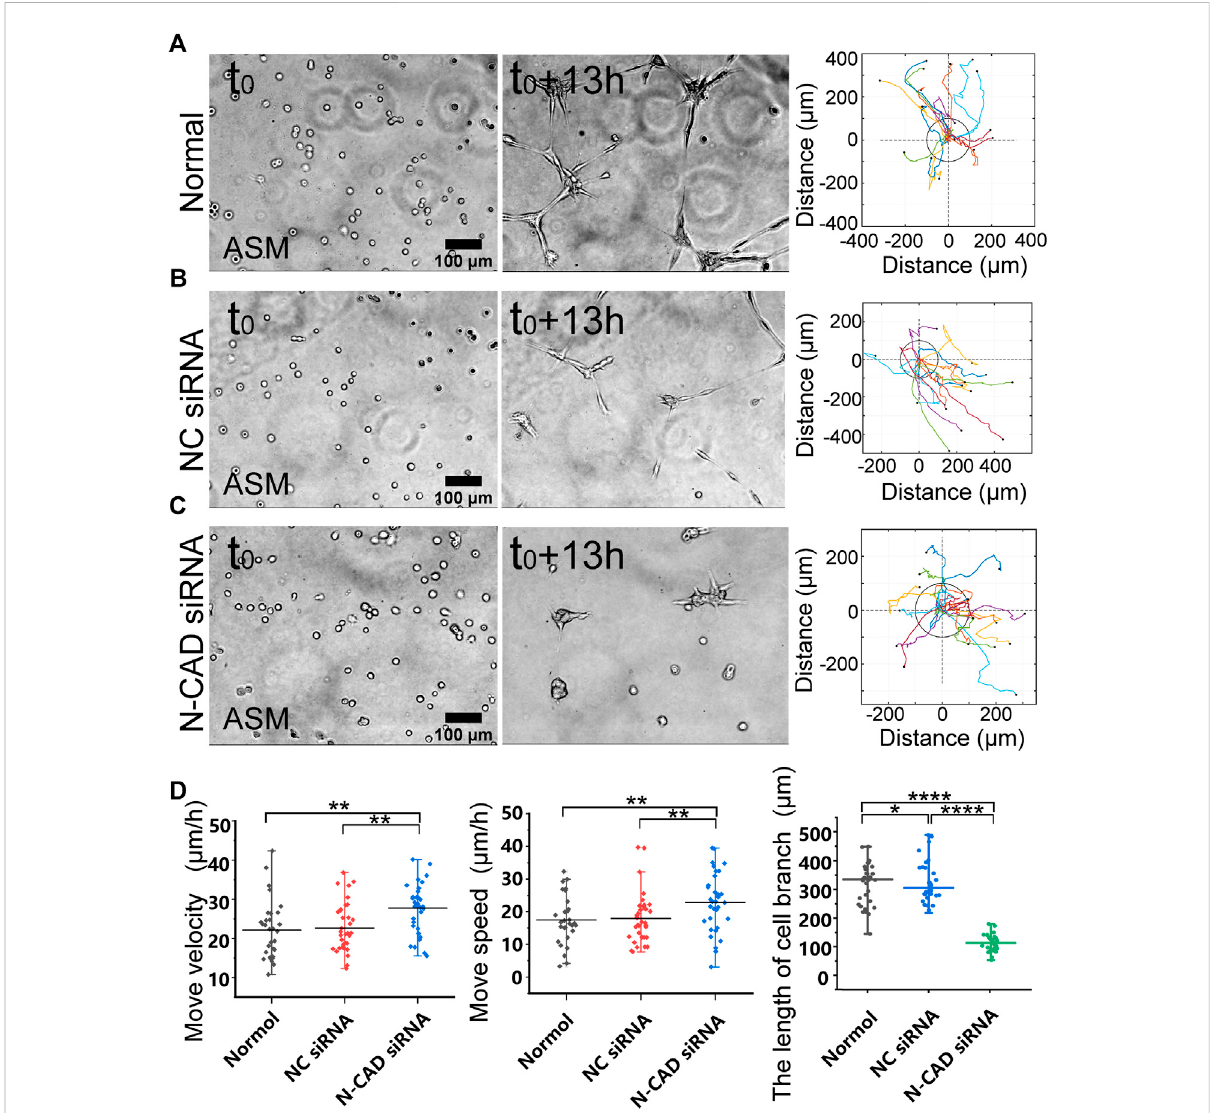
FIGURE 4 N-cadherin in regulating cell branching formation. ASM cells were transfected with N-cadherin (N-CAD) or control siRNA, and after 72 h, the cells were seeded on the hydrogel for time-lapse imaging. (A – C) ASM cells branch assembly and trajectory analysis under normal condition (A) , or transfected with control siRNA (B) or N-CAD siRNA (C) . Cells transfected with N-CAD siRNA formed clusters without further migration later, and the fi rst 13-h images were analyzed. (D) Statistical quanti fi cations of ASM cell move velocity and speed ( n = 33, 34, 37, respectively) and lengths of assembled branches ( n = 29, 29, 38, respectively) under the indicated conditions of (A – C)